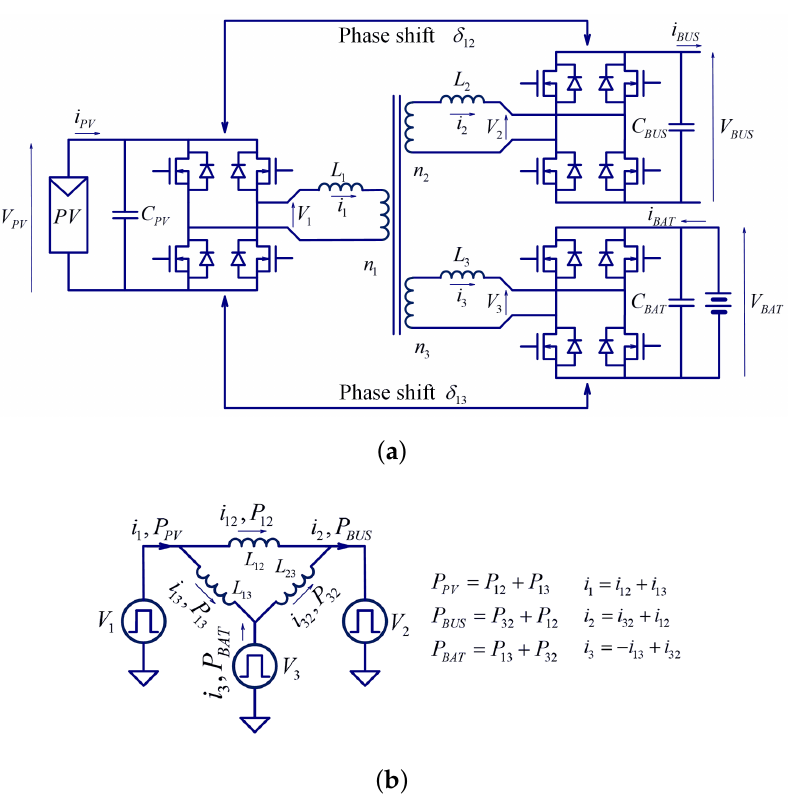
Figure 2. a) TAB circuit topology. Figure 2. ( a ) TAB circuit topology. ( b ) ∆ -transformed equivalent b) ∆ -transformed equivalent model.